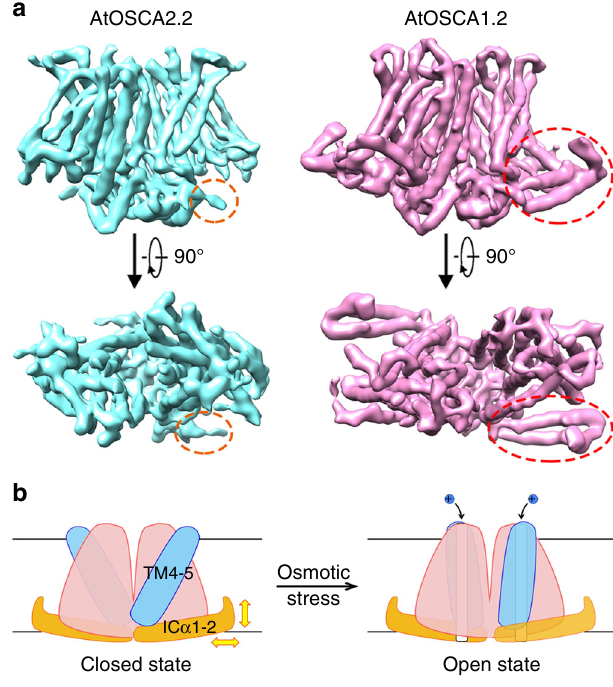
Fig. 5 Comparison of the EM maps between AtOSCA1.2 and AtOSCA2.2. a The two long helices and the anchor region in the cytosolic domain are missing in the structure of AtOSCA2.2. A structure of AtOSCA2.2 was determined at 5.4 Å resolution by single-particle cryo-EM analysis. Comparing with AtOSCA1.2, AtOSCA2.2 lacks the two long helices and the hydrophobic linker in its cytosolic domain, as indicated by the dashed-line circles. A 5.4 Å low-pass fi ltered map for AtOSCA1.2 is presented here for comparison. The structures of AtOSCA2.2 and AtOSCA1.2 are coloured cyan and magenta, respectively. b A cartoon model for